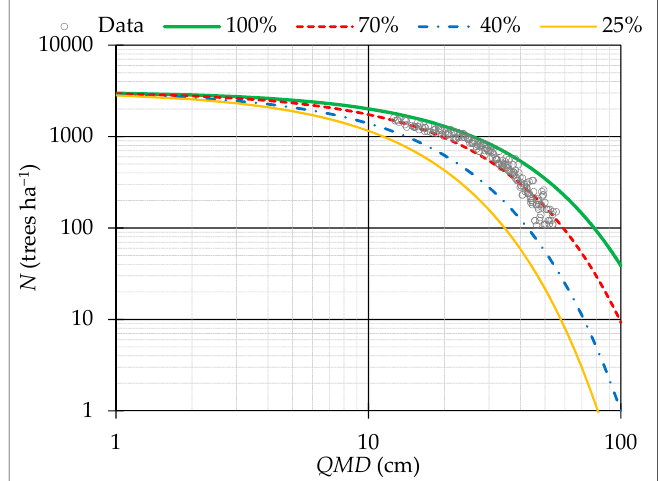
Figure 4. DMG with common initial density and variable slope for nonlinear exponential equation